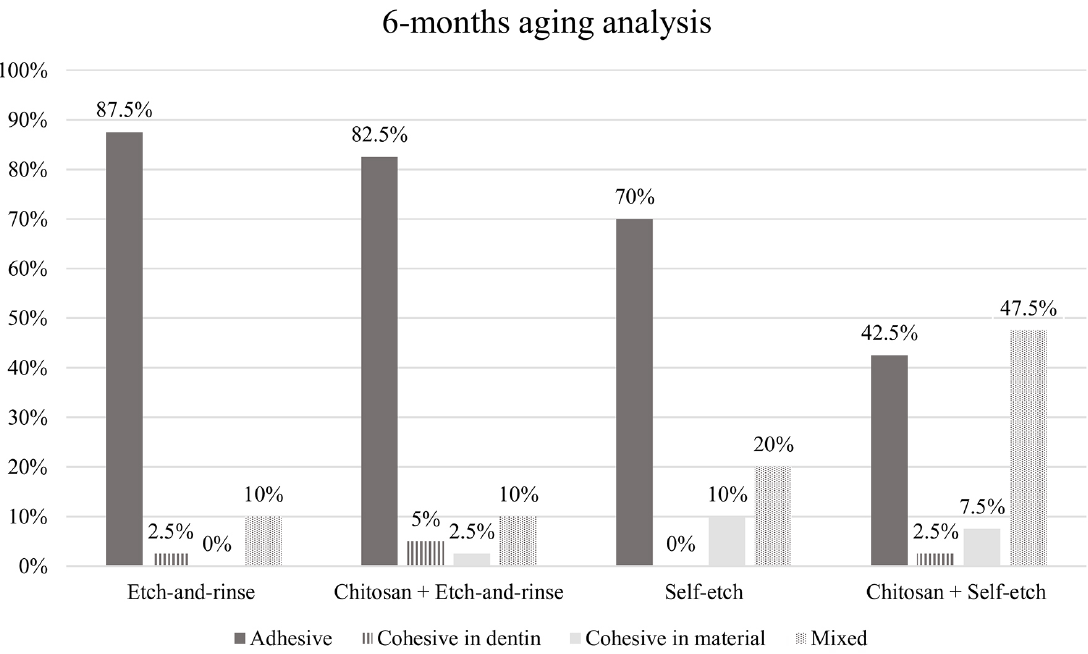
Figure 3- Failure pattern distribution (%) for microtensile bond strength of specimens after the aging process of the adhesive interface (6-months water-storage + bacterial